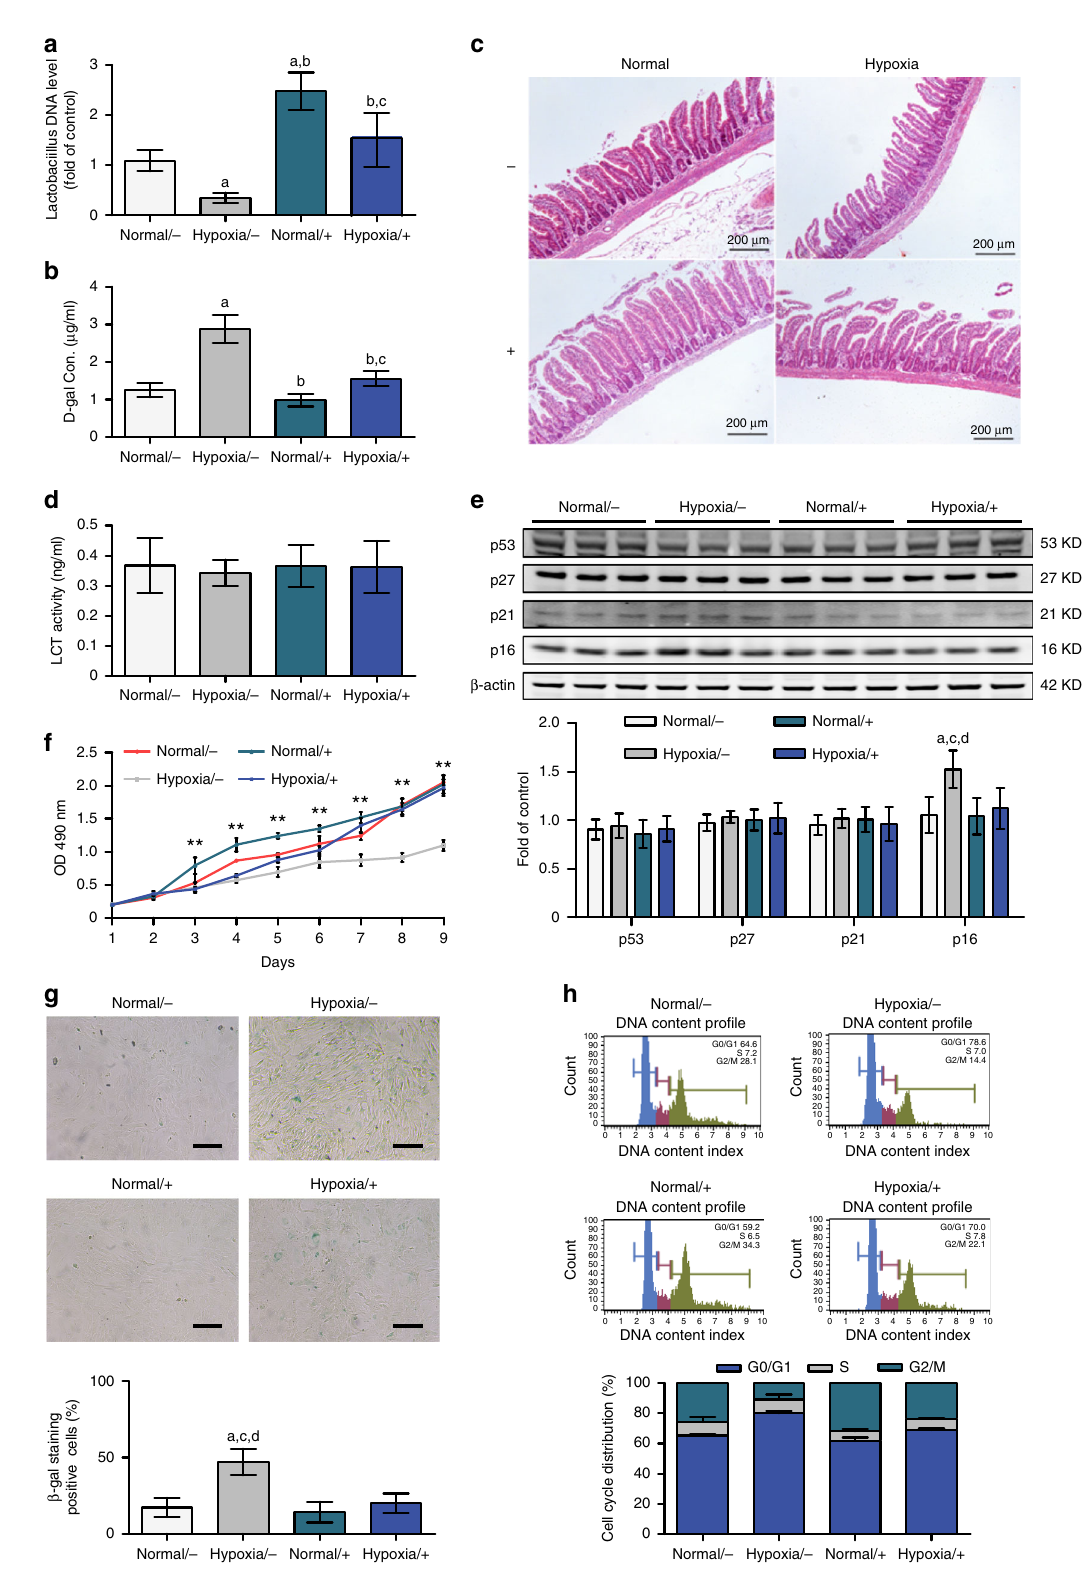
DNA content profile DNA content